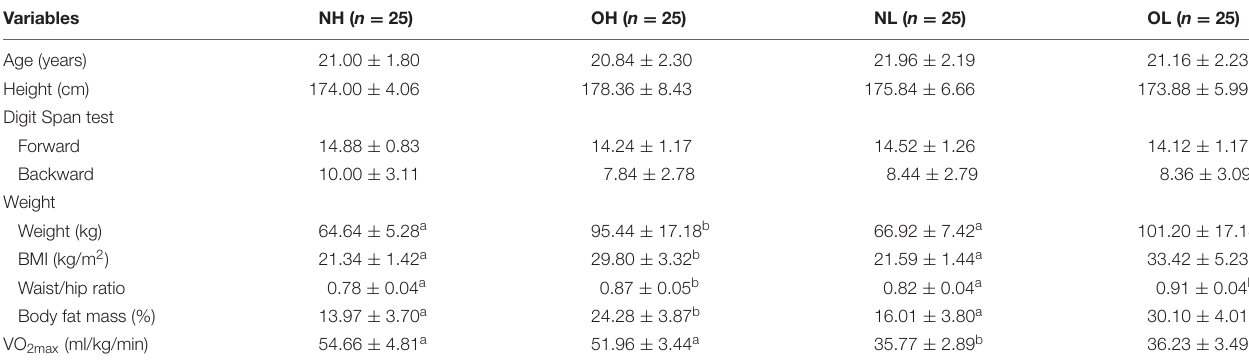
TABLE 1 | Demographic and cardiovascular fitness characteristics among four groups (mean ±